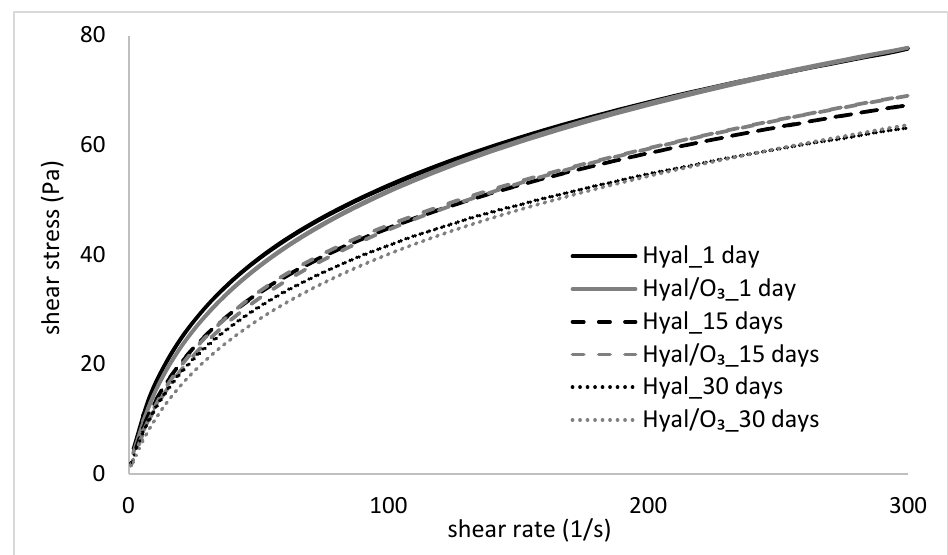
Figure 4. Flow cures of the Hyal and Hyal/O ₃ samples, measured at 1, 15 and 30 day of storage. Table 1. The parameters of Herschel–Bulkley rheological model.